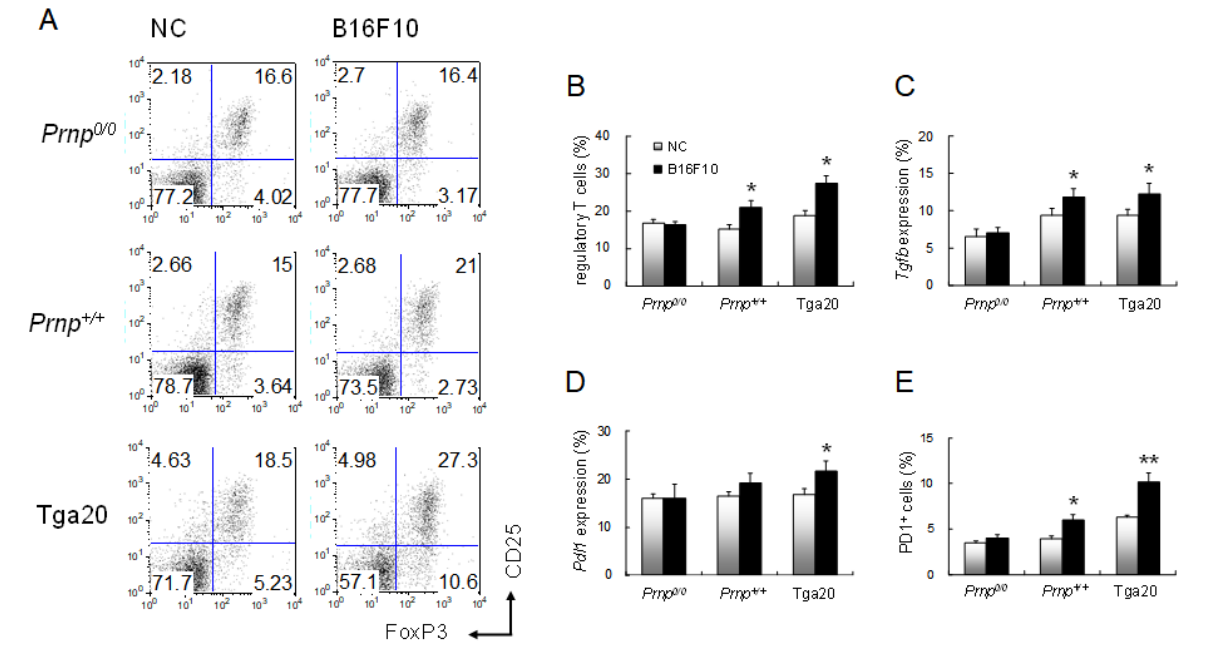
Figure 3. Analyses of Treg cells in the spleens of the negative control (NC) and B16F10-treated groups at the terminal stage of lung cancer. ( A ) Flow cytometric analysis of FoxP3 and CD25 expression in CD4 + CD3 + gated cells. ( B ) The number of Treg cells calculated from flow cytometric plots. ( C ) mRNA levels for Tgfb . ( D ) mRNA levels for Pdl1 . Relative mRNA levels were measured by quantitative real-time PCR and normalised to Actb expression (100%). ( E ) Flow cytometric analysis of CD3 + PD1 + cells (%). Data are for an average of 12 mice per group. Error bars represent mean values ± standard deviation. * p < 0.05 and ** p < 0.01.